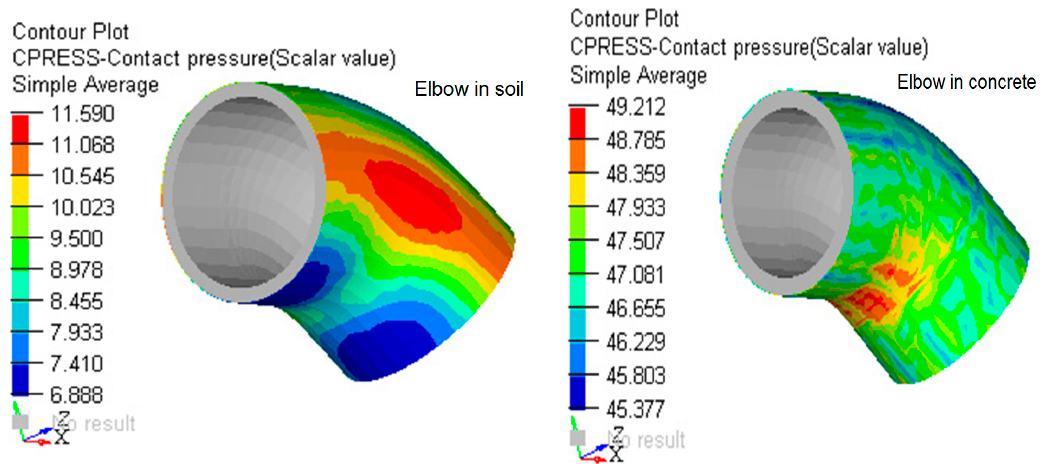
Figure 21. Displacements in section of elbow, in mm (load pressure 50 MPa).